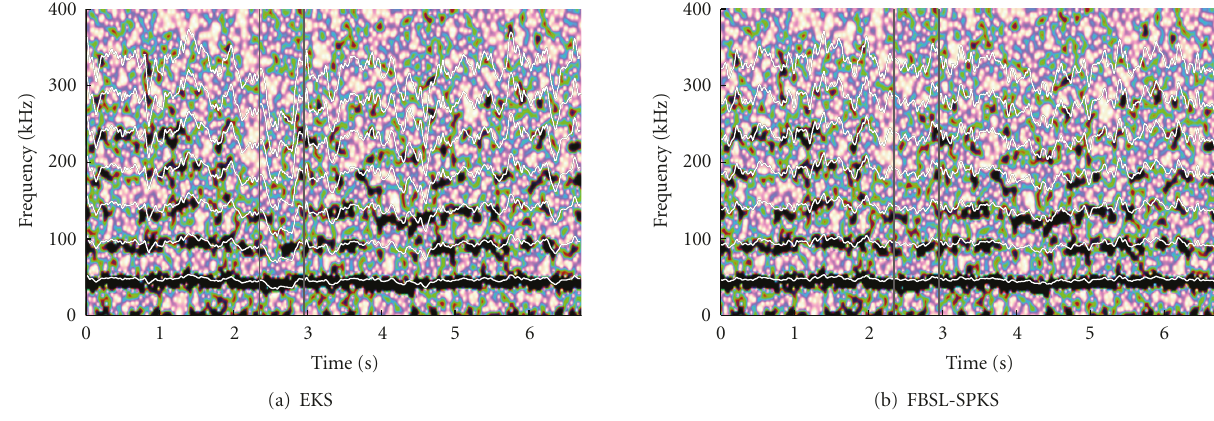
Figure 7: (a) Estimated frequency using the EKS on top of the spectrogram of a photosensor insect activity signal. (b) Estimated frequency using the FBSL-SPKS on top of the spectrogram of a photosensor insect activity